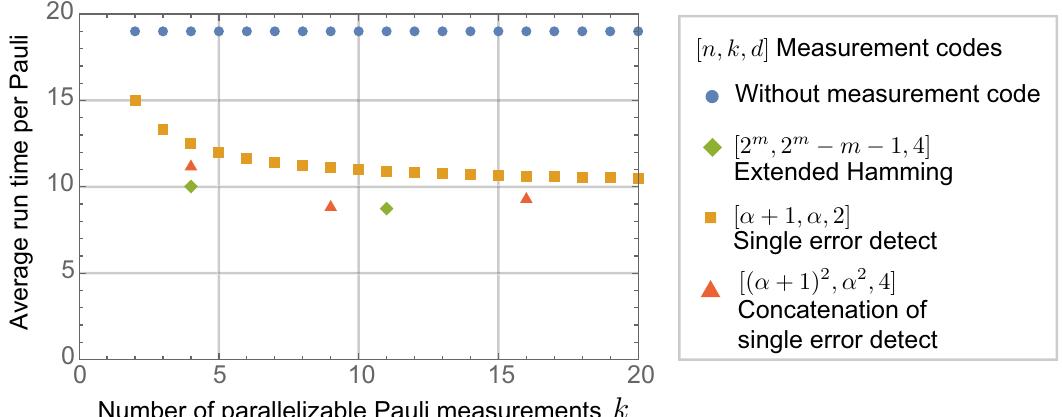
FIG. 13. A comparison of the standard lattice-surgery approach (without the measurement code) with three different TELS schemes for performing a set of k parallelizable Pauli measurements. We assume that the Pauli measurements give an incorrect outcome due to a timelike failure with a probability determined by Eq. (3) with d x (cid:6) = 100 and p = 10 − 3 . We set the allowed error per Pauli at δ = 10 − 15 . The [2 m , 2 m − m − 1, 4] are well-known Hamming codes. The [ α + 1, α , 2] are single error-detection codes and [ (α + 1 ) 2 , α 2 , 4] are concatenated single error-detection codes. While there are big jumps in k between the best-performing codes, these jumps could be partially smoothed out by considering other codes such as concatenated codes with different inner and outer code sizes, such as the [ (α + 1 )(β + 1 ) , αβ , 4] codes. We also consider the triply concatenated codes with parameters [ (α + 1 ) 3 , α 3 , 8] but they perform poorly in the parameter regime shown here and so are omitted for